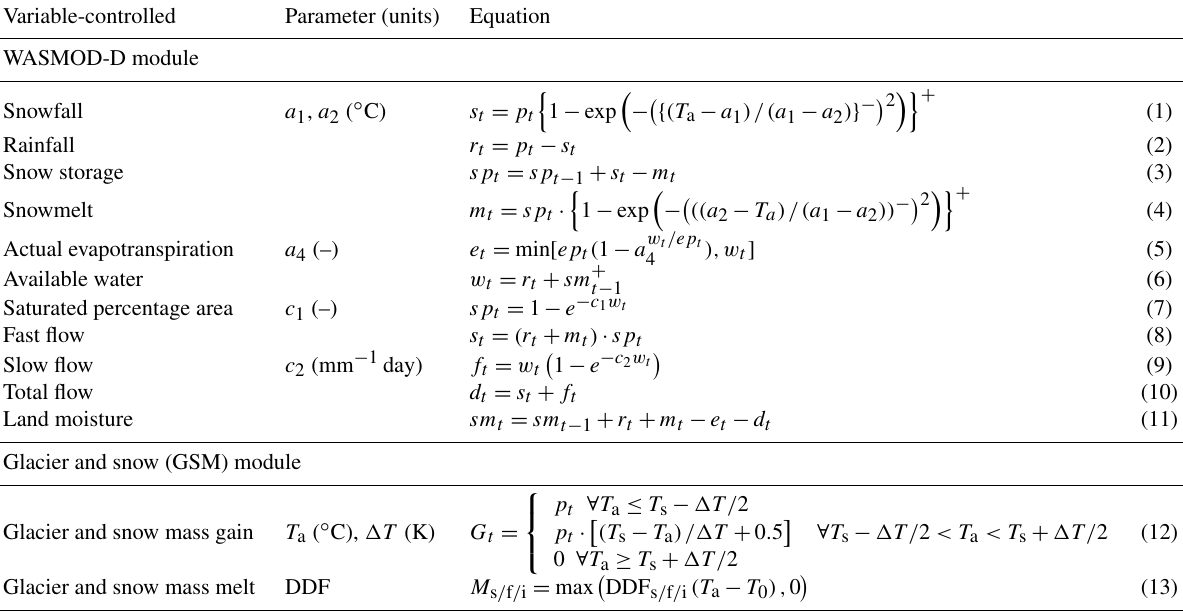
Table 1. Daily GSM-WASMOD equations and parameters. Variable-controlled Parameter (units) Equation WASMOD-D